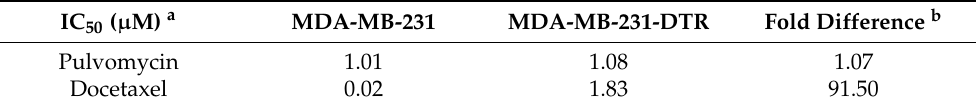
Table 2. Drug resistance profiles of MDA-MB-231 cells with resistance to